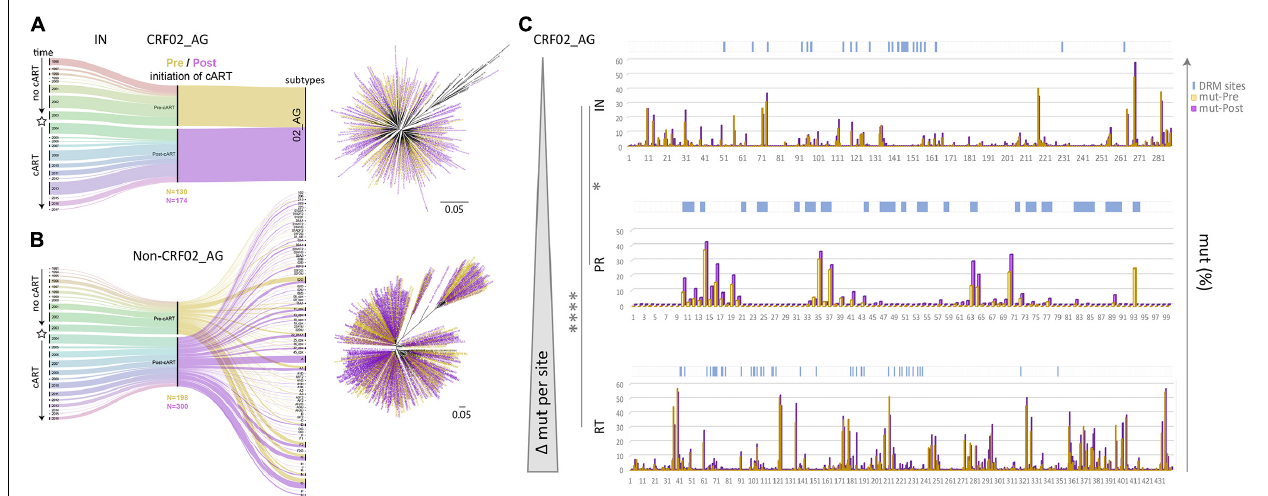
FIGURE 3 | Data segregation, phylogenetic analysis, and comparison of drug resistance mutations and naturally occurring polymorphisms in Cameroonian HIV-1 pol IN, PR, and RT sequences before and after regional implementation of cART. (A,B) HIV-1 IN sequences from Cameroonian HIV-1-infected individuals (as in Figure 2 ) were segregated into CRF02_AG (A) and non-CRF02_AG data sets (B) . The data set composition by sampling year and lineage/subtype is summarized in alluvial diagrams. Asterisks indicate the subcategorization of sequences collected pre- and post-implementation of cART in Cameroon (2004) along the timeline; sequences are colored yellow (Pre) and purple (Post), respectively. Pre and Post sample numbers are indicated below the plots. Phylogenetic placement of Pre and Post sequences is shown in maximum-likelihood RAxML trees with the same yellow/purple color code. The scale indicates a 5% genetic distance. (C) Comparison of site-specific frequencies of mutations (mut) including naturally occurring polymorphisms (NOP) in Cameroonian HIV-1 pol IN, PR, and RT sequences before and after regional implementation of cART. CRF02_AG consensus sequences (derived from the pre-cART data sets) served as references to summarize all amino acid mutations per site. Their relative frequencies (%) are compared side-by-side for Pre and Post data sets in bar graphs. Locations of canonical DRMs (according to the Stanford drug resistance database, November 2020) are indicated with blue ticks on top of the charts. The bar charts are sorted from top to bottom according to increasing mutational difference from Pre to Post per site. Stars indicate statistical differences in a Kruskal Wallis test with Dunn’s multiplicity correction (* < 0.05, **** <